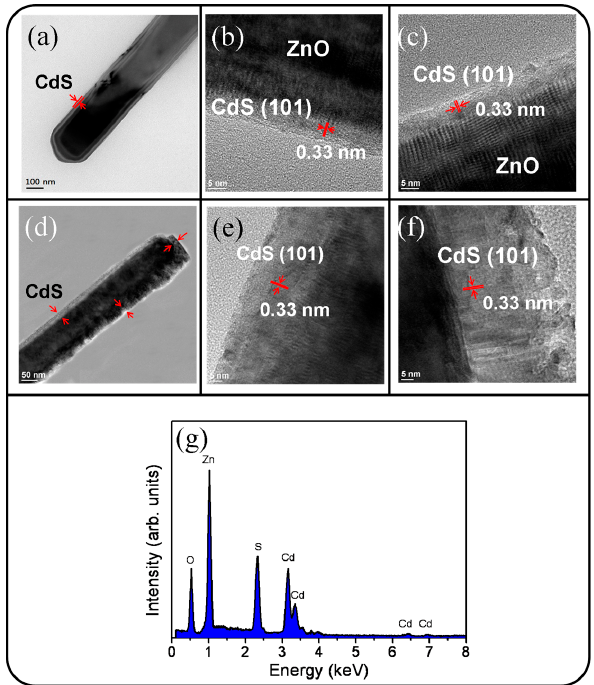
Figure 3. TEM analyses of the ZnO-CdS rods: ( a ) Low-magnification TEM image of the ZnO-CdS (5 nm) nanorod; ( b , c ) HRTEM images taken from the local regions of the nanorod; ( d ) Low-magnification TEM image of the ZnO-CdS (20 nm) nanorod; ( e , f ) HRTEM images taken from the local regions of the nanorod; ( g ) EDS spectrum taken from the nanorod.